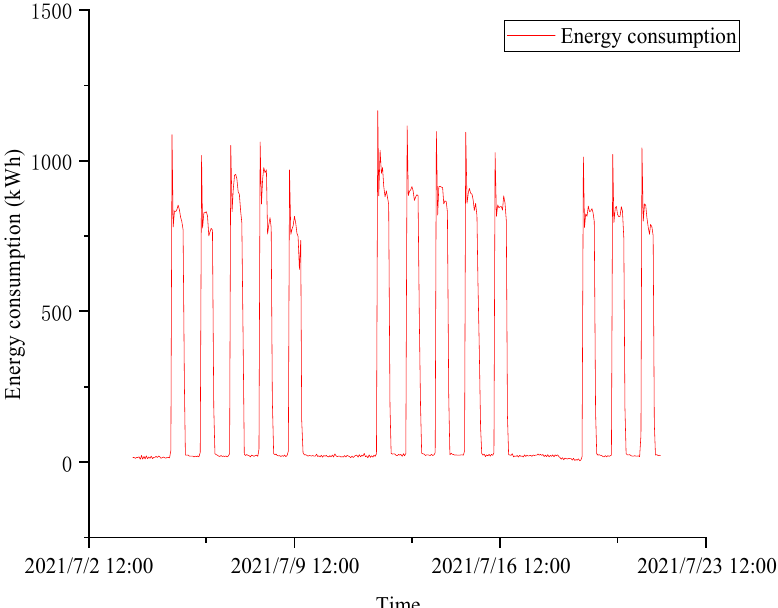
Figure 3. Variation of air-conditioning energy consumption of a government office building in Ningbo during 4 July 2021 to 21 July 2021 .